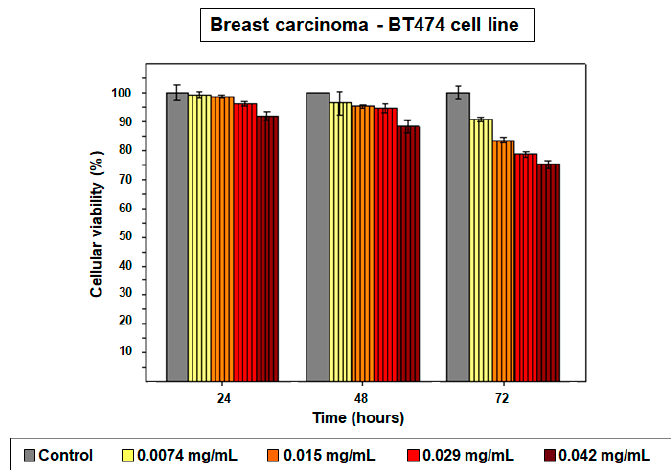
Figure 3. The results of the MTT assay carried out with PD NPs with a size of 420 nm (vertical lines— pattern bars) with BT474 cells. The same four concentrations (0.0074, 0.015, 0.029 and 0.042 mg/mL) of PD NPs as before were employed. The results shown are the mean ± SD of three replicates for each treatment.